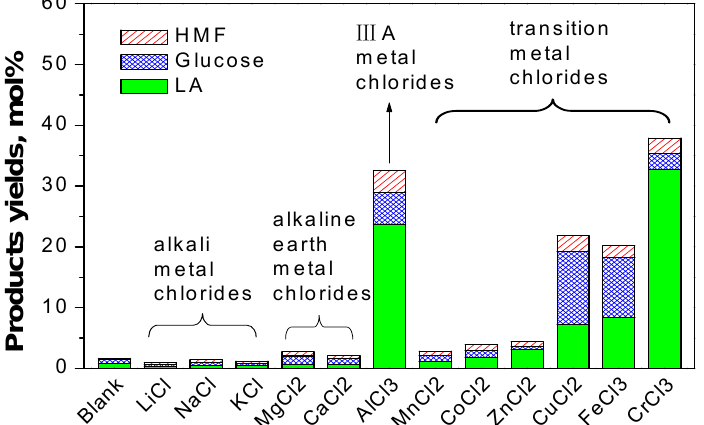
Figure 2. Catalytic effects of metal chlorides on the conversion of cellulose.